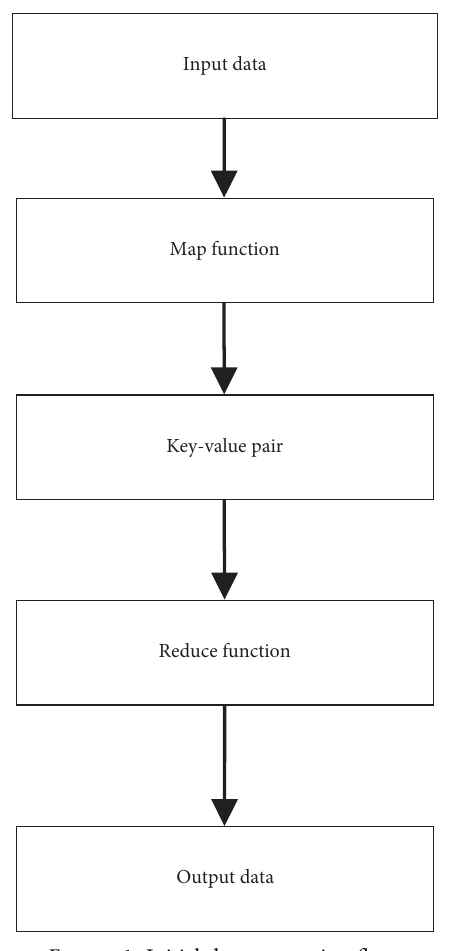
Figure 1: Initial data processing